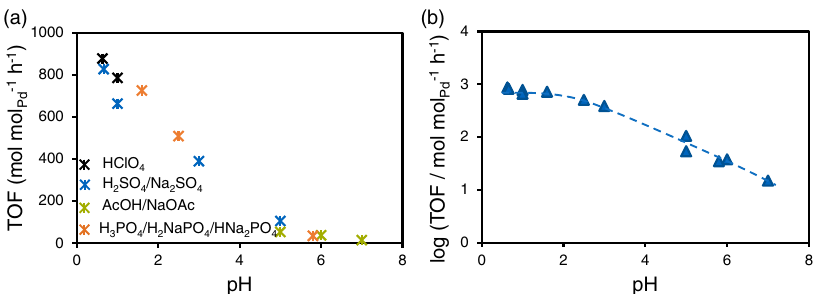
Fig.1|In fl uenceofpHontheactivityofbenzylalcoholhydrogenolysis.a TOFas a function of pH in the catalytic conversion of benzyl alcohol to toluene on Pd/C. b Log TOF as a function of pH to obtain the apparent reaction order in bulk